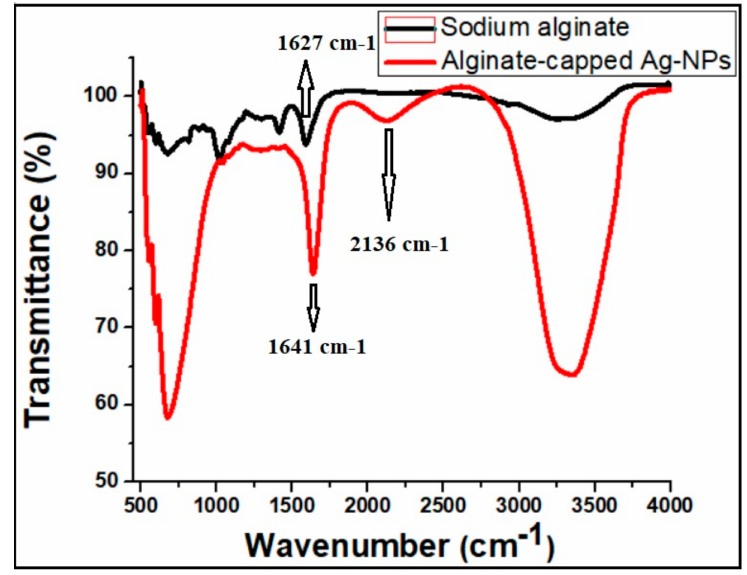
Figure 3. Fourier transform infrared spectroscopy (FTIR) spectra of the